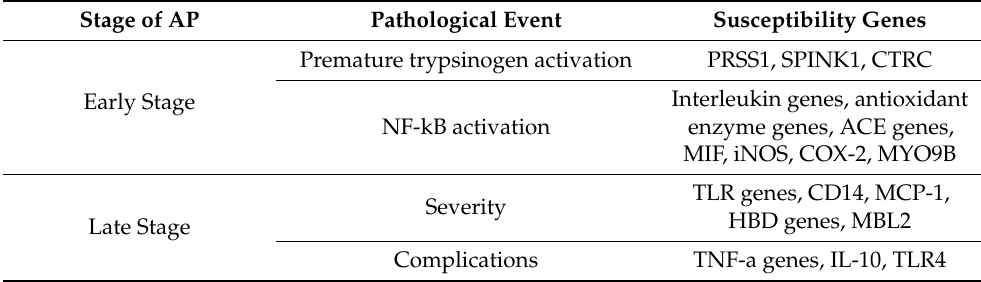
Table 1. Genetic susceptibility of acute pancreatitis (based on [25]). Stage of AP Pathological